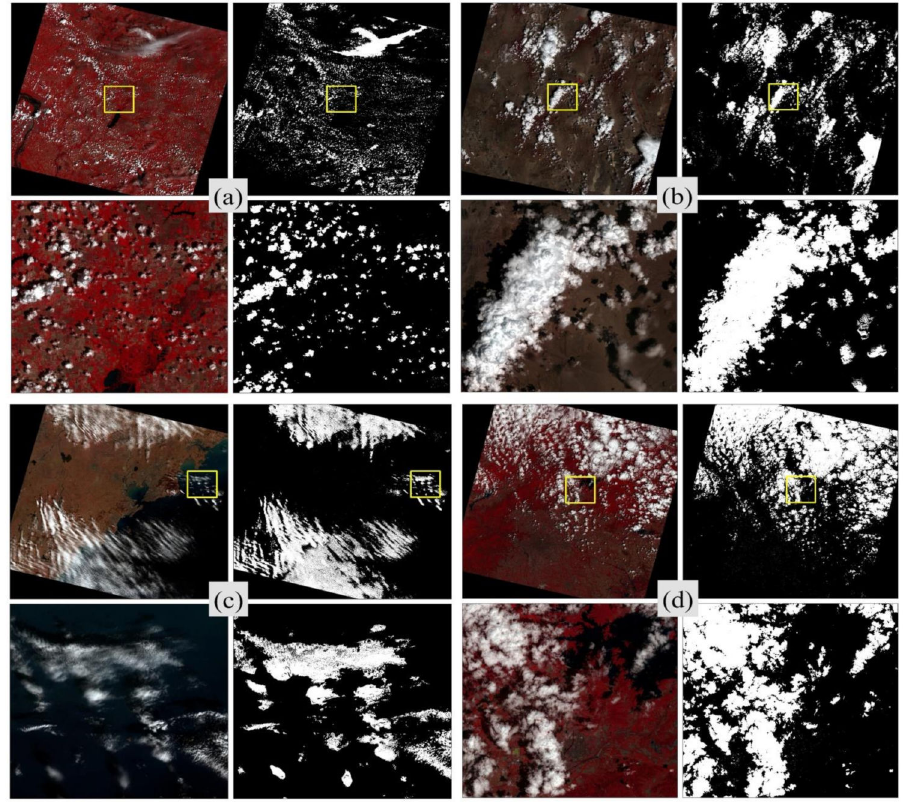
Figure 6. Examples of false-colour (RGB: bands 5, 4, and 3) composite images and cloud (masked white) detection results for Landsat-8 full-scene and enlarged-in images (areas outlined by yellow boxes) over diverse underlying surfaces: ( a ) vegetation and inland water areas, acquired on 3 July 2019, at Path 23 and Row 33; ( b ) bare soil areas, acquired on 29 July 2019, at Path 40 and Row 34; ( c ) ocean, sand, vegetation, and urban areas, acquired on 20 May 2017, at Path 118 and Row 38; ( d ) vegetation and urban areas, acquired on 30 June 2019, at Path 123 and Row